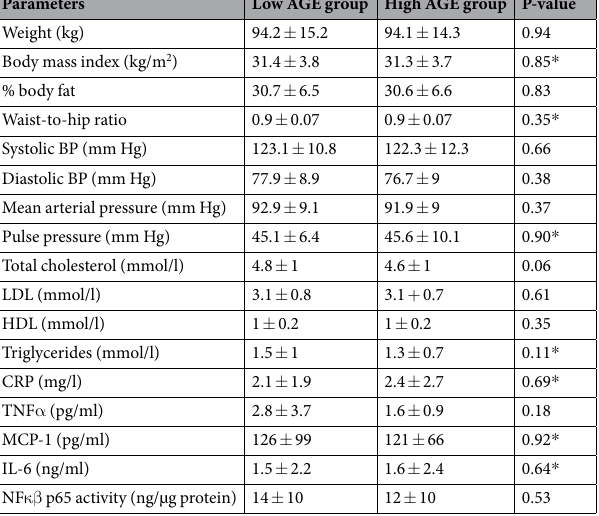
Table 1. Participants’ baseline characteristics at the beginning of each study period (n = 20). All values are presented as means ± SDs. Paired t-tests were conducted to determine the p-values. * Data transformation was done. BP, blood pressure; CRP, C-reactive protein; HDL, high-density lipoprotein; IL-6, interleukin -6; LDL, low-density lipoprotein; MAP, mean arterial pressure; MCP-1, monocyte chemoattractant protein-1; NF κβ ; Nuclear factor kappa beta; PP, pulse